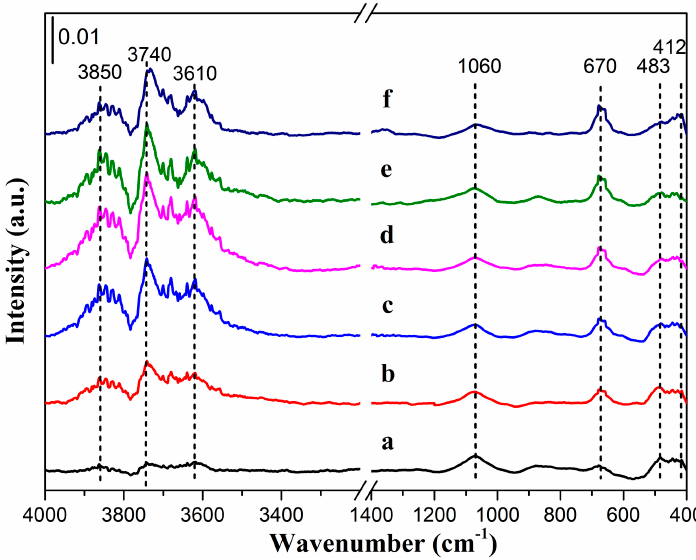
Figure 6. ATR ‐ FTIR spectra of the Ni surfaces: ( a ) untreated; ( b ) etched by HCl; ( c ) etched by H 2 SO 4 ; ( d ) etched by H 3 PO 4 ; ( e ) etched by HNO 3 ; and ( f ) etched by HF.